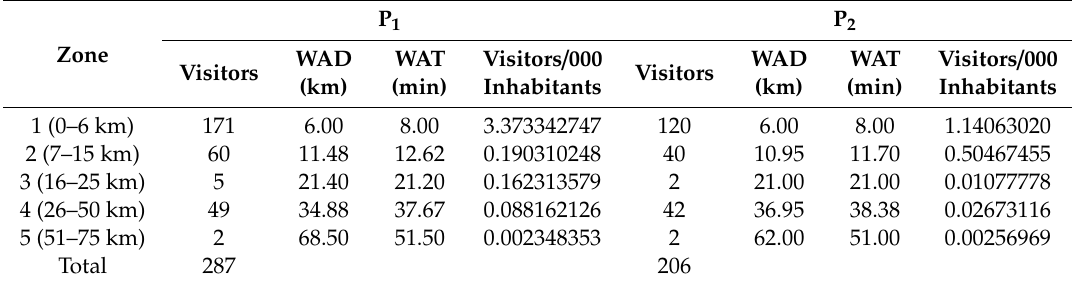
Table 5. Weighted Average Distance (WAD) and Weighted Average Time (WAT) taken by visitors of MTNP for both periods.